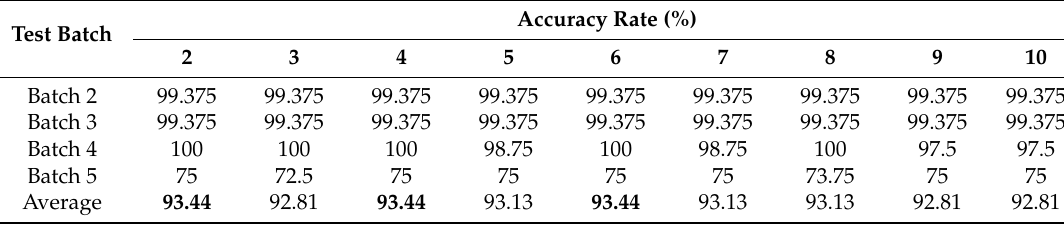
Table 2. The performance of QWKFDA using Gaussian kernel with the number of base kernels from 2 to 10.